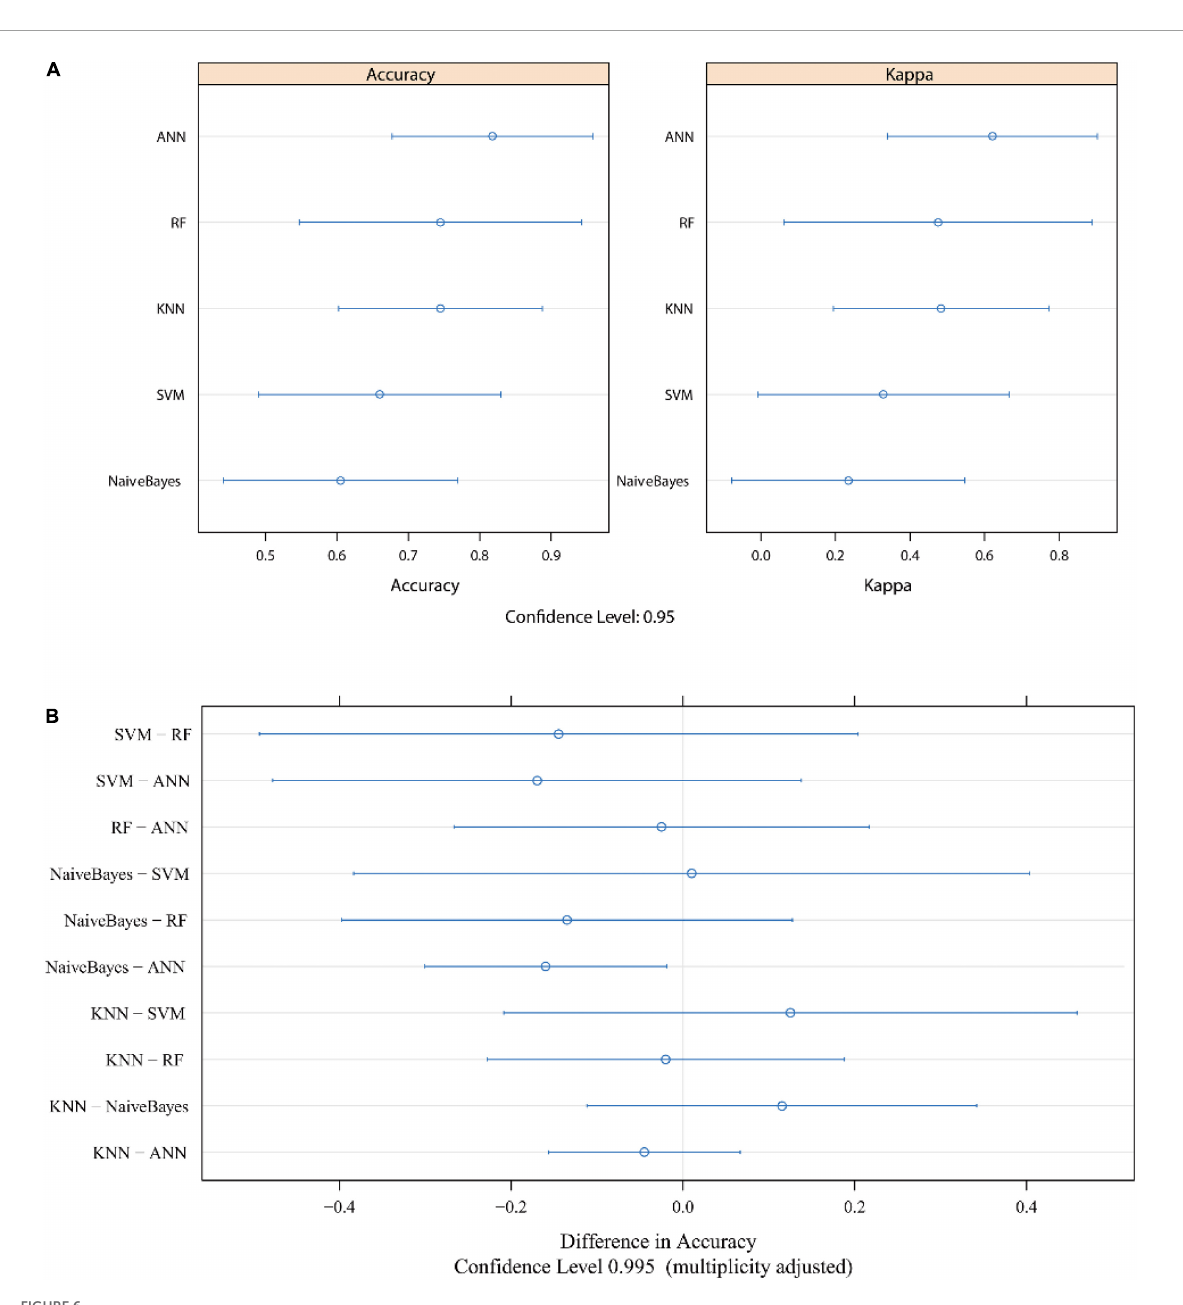
FIGURE6 The evaluation of each model after cross validation. The accuracy and Kappa value are shown in panel (A) . Bonferroni’s test results are shown in panel (B) . The median numbers are represented by dots, and lines indicate the confidence level. ROC, receiver operating characteristic; AUC, area under the curve; KNN, k-nearest neighbor; SVM, support vector machine; RF, random forest; ANN, artificial neural